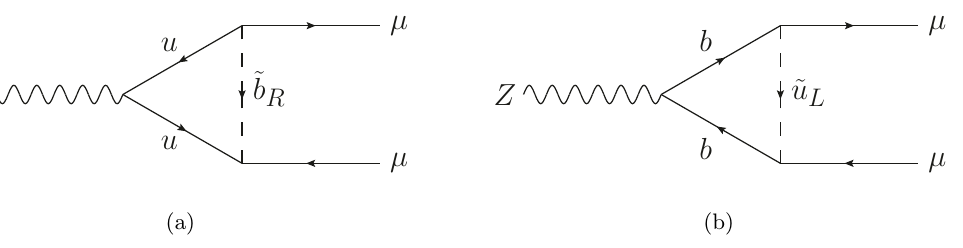
Figure 5 . Example one loop Feynman diagrams contributing to Z ! (cid:22)(cid:22)